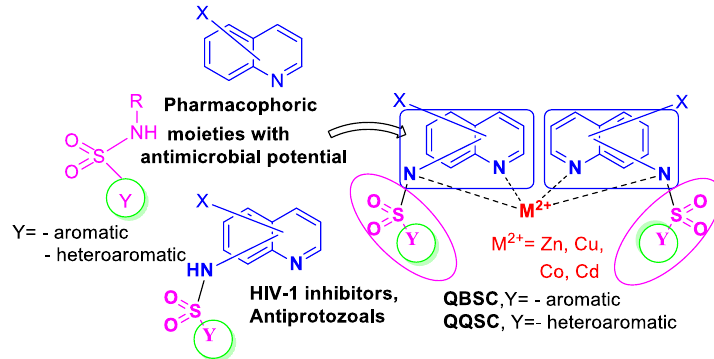
Scheme 1. Design in the class of hybrid quinoline-sulfonamide complexes derivatives.